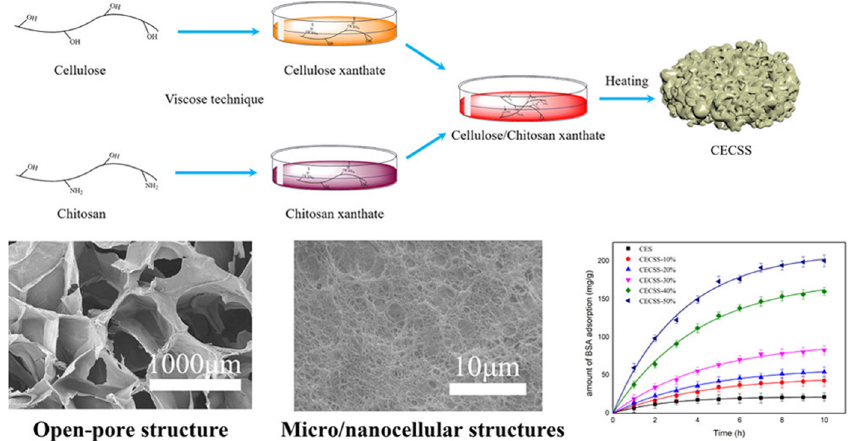
Figure 10. Schematic presentation of cellulose chitosan composite sponge formation with the micro- graphs of the sponges’ open-pore structure and the influence of chitosan content onto BSA adsorption efficiency. Reprinted (adapted) with permission from Liu, C.; Yu, J.; You, J.; Wang, Z.; Zhang, M.; Shi, L.; Zhuang, X. Cellulose/Chitosan Composite Sponge for Efficient Protein Adsorption. Industrial & Engineering Chemistry Research 2021, 60, 9159–9166 [81]. Copyright 2021 American Chemical Society.